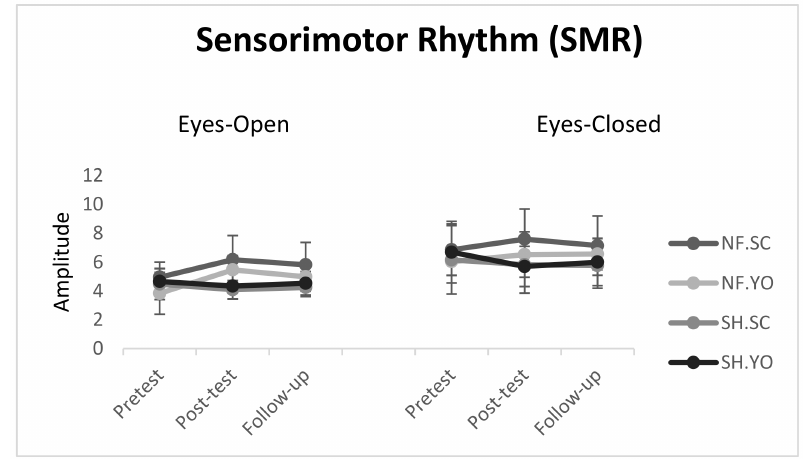
Figure 6. Line chart of Sensorimotor Rhythm (SMR) power during pretest, post-test, and follow-up. Error bars represent the standard deviation. NF.SC: neurofeedback/self-controlled practice; NF. YO: neurofeedback/yoked practice; SH.SC: sham/self-controlled practice; SH. YO: sham/yoked